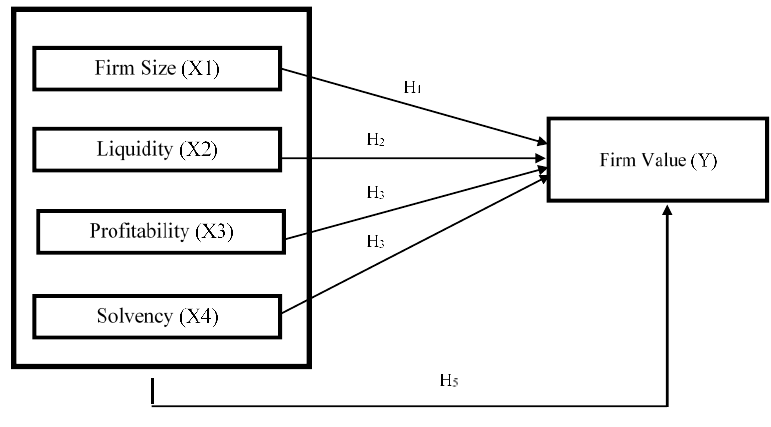
Figure 1 : The Effect of Firm Size, Liquidity, Profitability and Solvency on Firm